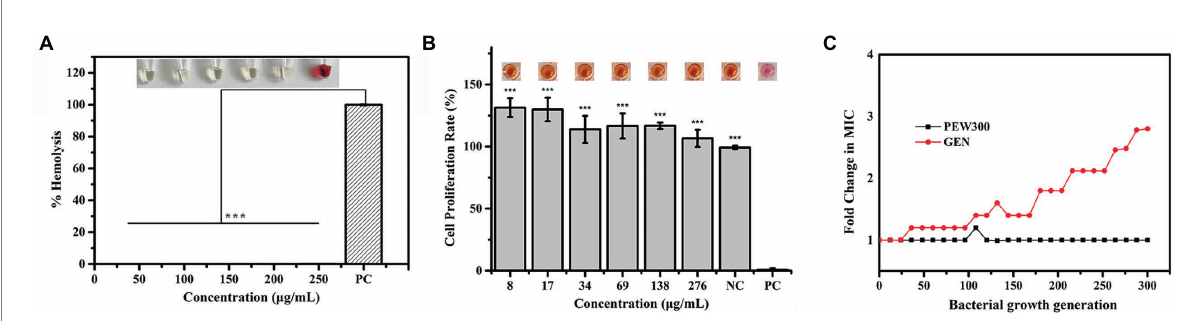
FIGURE 2 Hemolytic activity, cytotoxicity, and drug resistance of PEW300. (A) Hemolytic activity of PEW300 in mouse red blood cells. 0.1% Triton X-100 was used as the positive control (PC); *** p < 0.005 compared with PC group. (B) Cytotoxicity of PEW300 in HEK293 cells was determined by a CCK-8 assay. 0.1% Triton-X 100 and PBS were used as positive control (PC) and negative control (NC), respectively. Error bars represent the standard error from mean cell viabilities from three replicates, *** indicates p < 0.005 compared with PC group. (C) Drug resistance of the PEW300 and gentamicin. GEN, gentamicin.